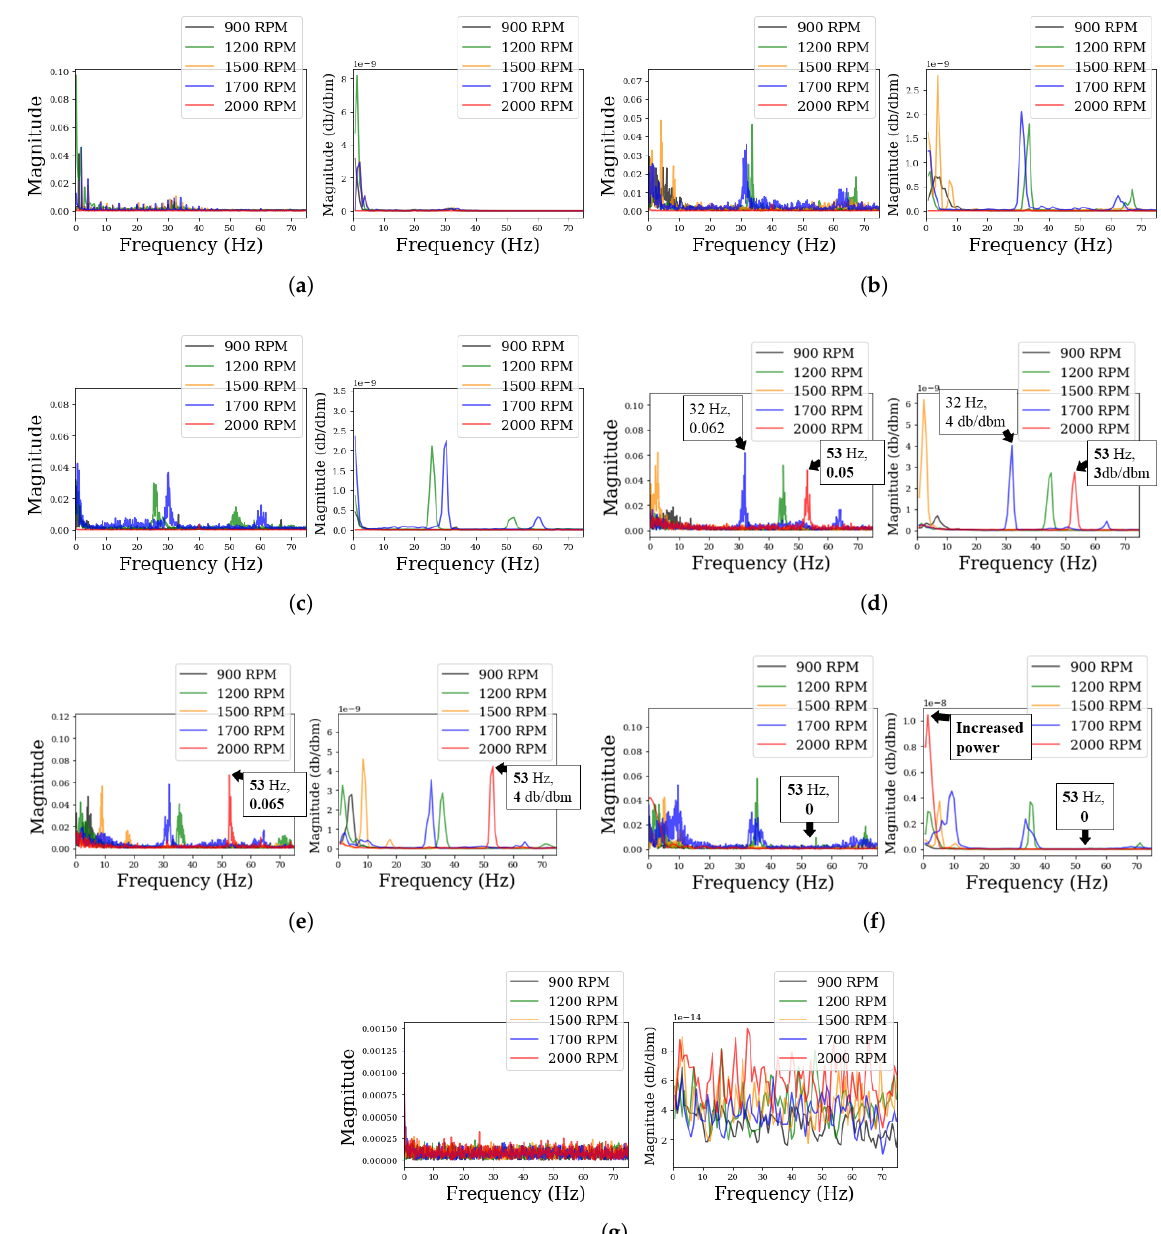
Figure 10. FFT (on the left) and PSD (on the right) spectra comparison of the standardized CR signals for different W/D emulsions at increasing engine speeds ( a ) EM-0%, ( b ) EM-1.3%, ( c ) EM-1.5%, ( d ) EM-2.0%, ( e ) EM-5.0%, ( f ) EM-10.0%, and ( g )